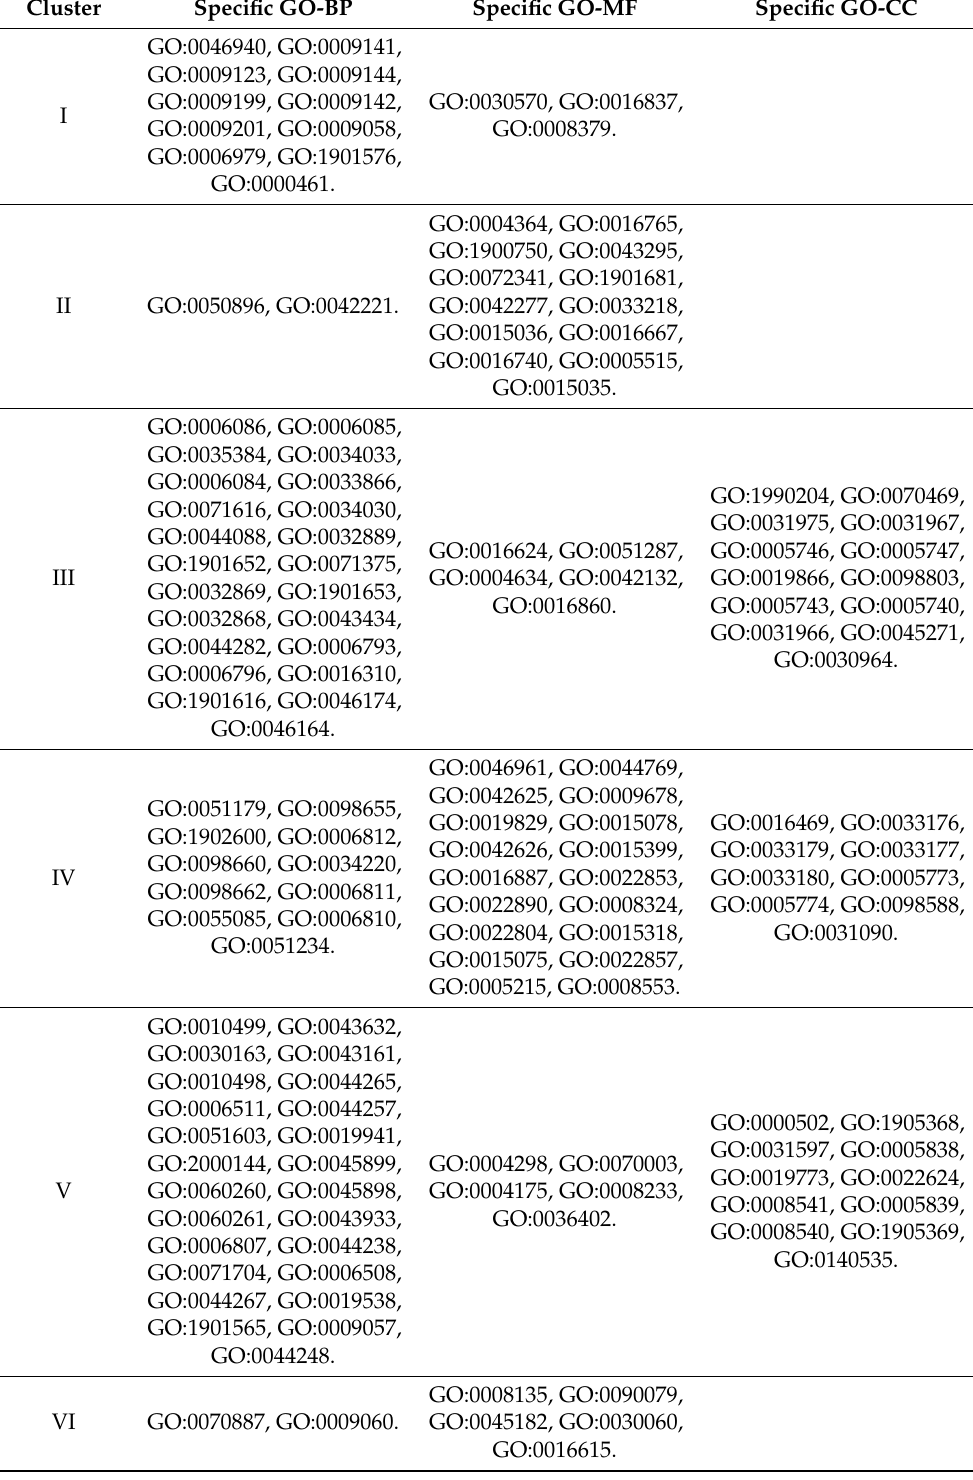
Table 2. Cluster-related subnetwork-specific GO terms. List of cluster-related subnetwork (I–VI) -specific gene ontology (GO) terms across the three domains: biological process (GO-BP), molecular function (GO-MF), and cellular component